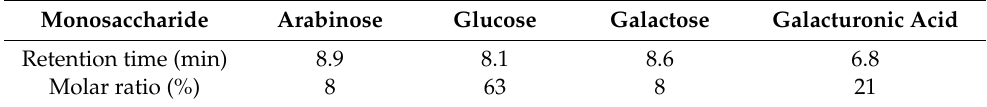
Table 1. Monosaccharide Composition and Molar Ratio of PPL-1.